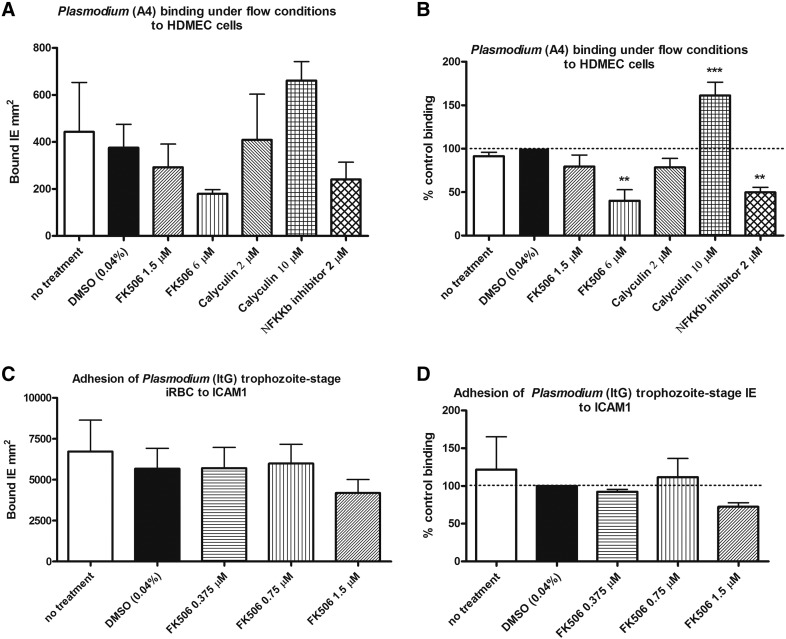
Effects of FK506 in Plasmodium-endothelial cell binding under flow and static conditions. (A) Adhesion of trophozoite-stage A4 IE after FK506 (1.5 or 6 μM), calyculin (2 or 10 μM), NFƘƘb inhibitor (2 μM), DMSO (0.04%) or no treatment of parasites under flow assay showing bound IE per mm2 or (B) percentage of control (DMSO treated) binding to human dermal microvascular endothelial cells (HDMEC). (C) Adhesion of trophozoite-stage ItG IE to protein ICAM-1 after FK506 (0.375, 0.75 or 1.5 μM), DMSO (0.04%) or no treatment under static conditions to ICAM1 showing bound IE per mm2 or (D) percentage of control (DMSO treated) binding. Bars represent mean ± S.E.M. Note differences in A4 erythrocyte binding among 3–5 independent experiments (P < 0.05 *, P < 0.01 **, P < 0.001 ***) under flow condition and no difference observed in ItG erythrocyte binding among three independent treatments (P > 0.05) under static condition.